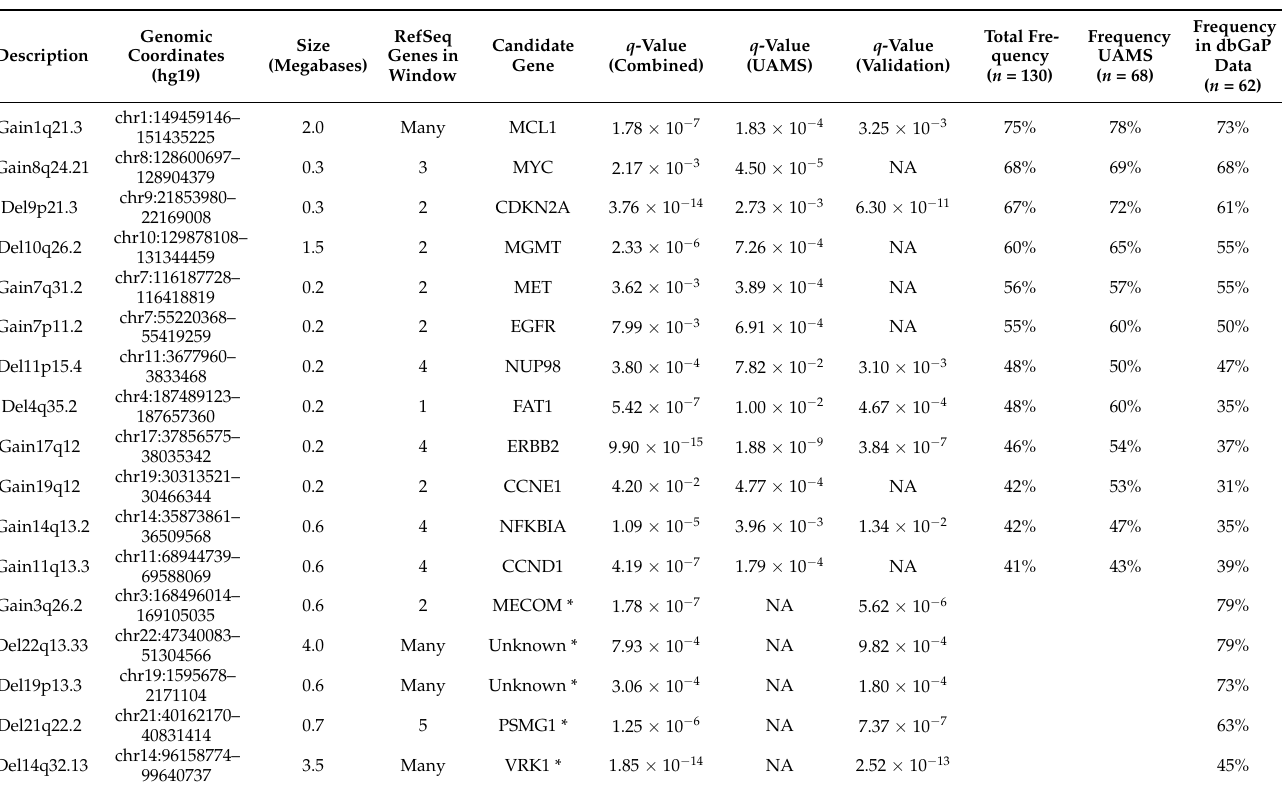
Table 3. Significant focal copy number events in BM, in order of overall frequency. Five features listed at the bottom of the table were only detectable in the comparison data set due to the coverage of the DNA capture